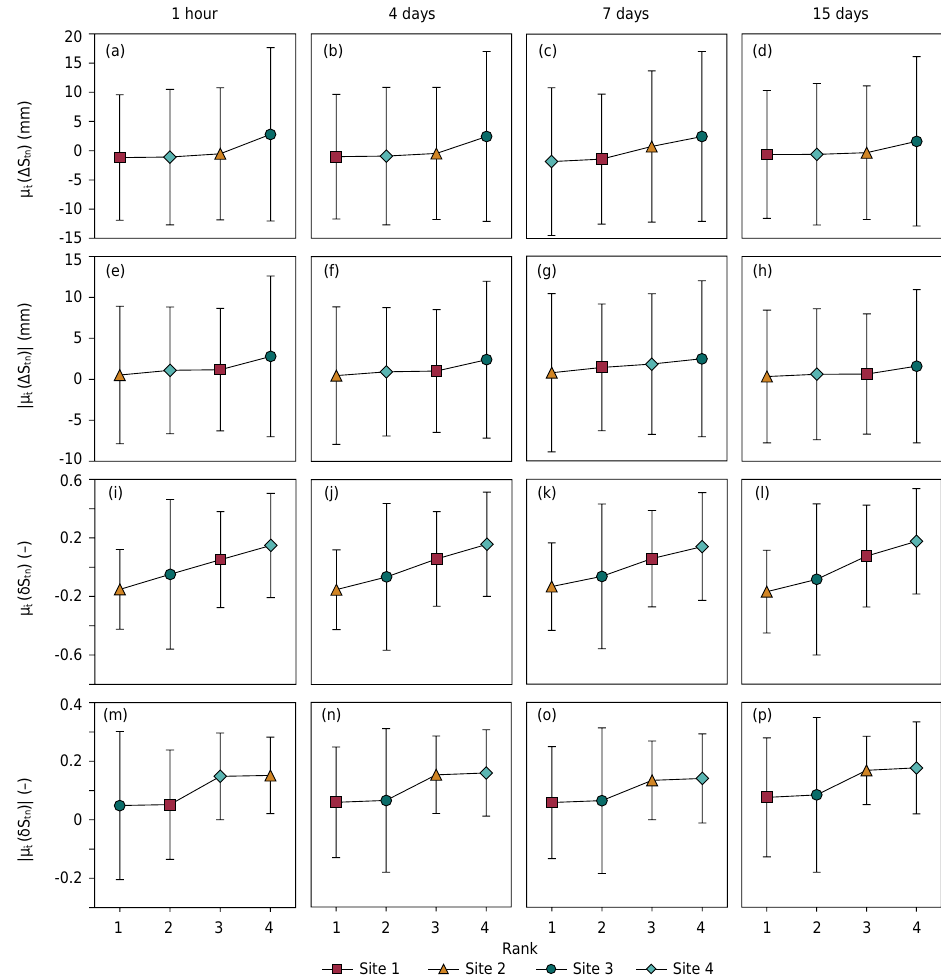
Figure 5. Ranking stability plots of temporal means of absolute Soil Moisture (SM) differences [µ t ̂ (ΔS tn )] (a, b, c, and d), absolute temporal means of absolute SM differences [|µ t ̂ (ΔS tn )|] (e, f, g, and h), temporal means of relative SM differences [µ t ̂ (δS tn )] (i, j, k, and l), and absolute temporal means of relative SM differences [|µ t ̂ (δS tn )|] (m, n, o, and